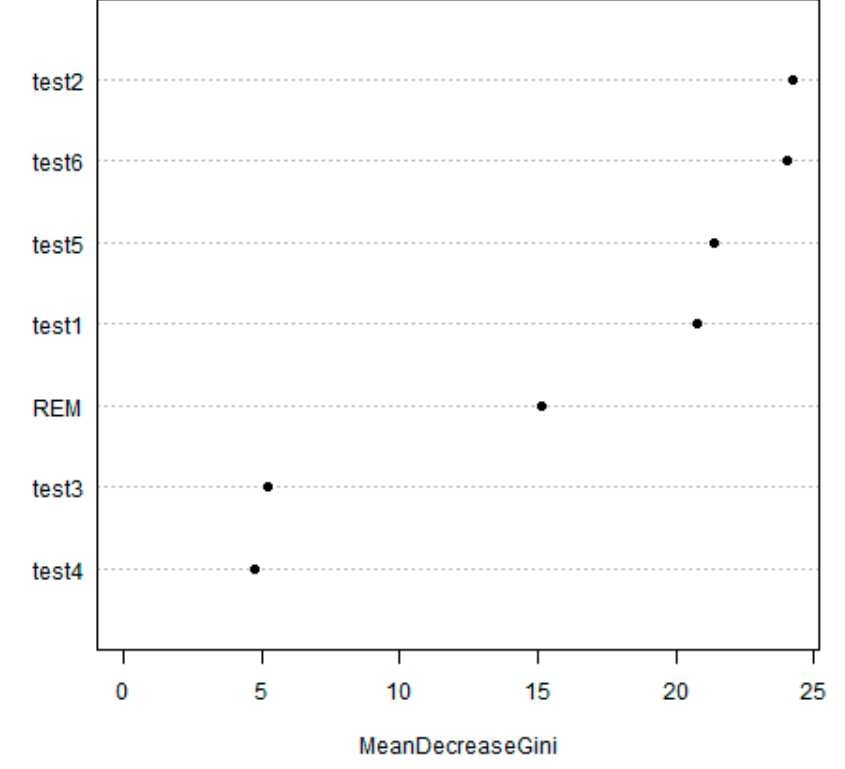
Figure 3. Variable importance in the Parkinson’s disease dementia (PDD) prediction model (random forest model). test1 = K-MMSE; test2 = K-MoCA; test3 = GDS; test4 = Global CDR score; test5 = sum of boxes in CDR; test6 = K-IADL; REM = Rapid eye movement and sleep behavior disorders.